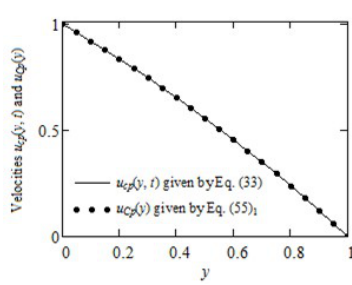
Figure 2. Comparison between the permanent the velocities u cp ( y , t ) and u Cp ( y ) for Re = 100, We = 0.3, α =